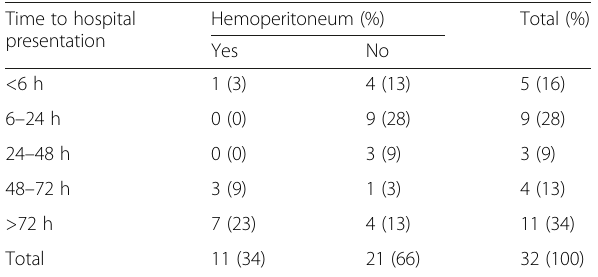
Table 5 Distribution of patients showing hemoperitoneum according to the time of hospital presentation Time to hospital presentation